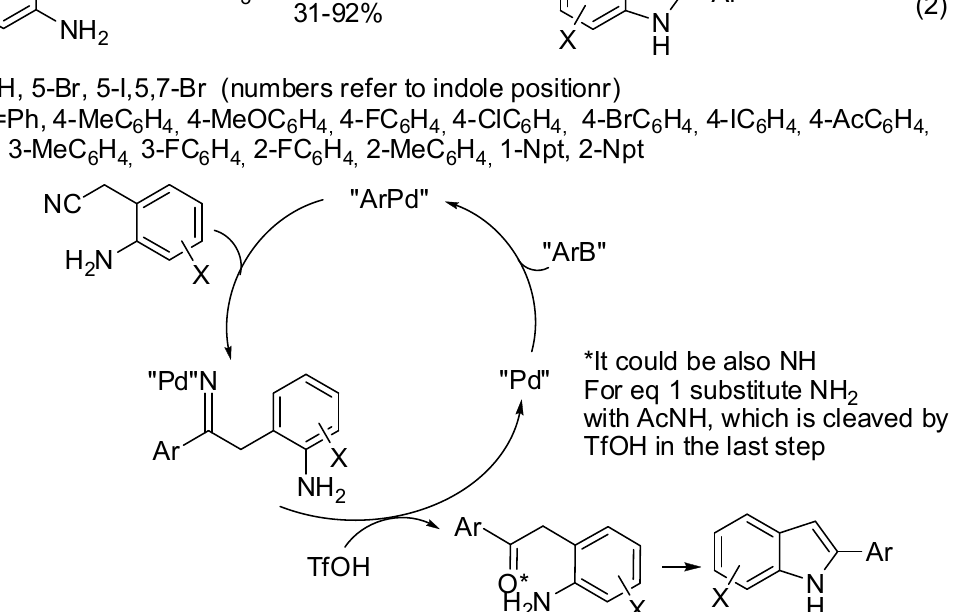
Table 1. Palladium catalyzed reactions of 2-haloanilines with alkynes to give indoles. 2-Haloaniline Alkyne Reaction Conditions Indole Yields (%) Ref